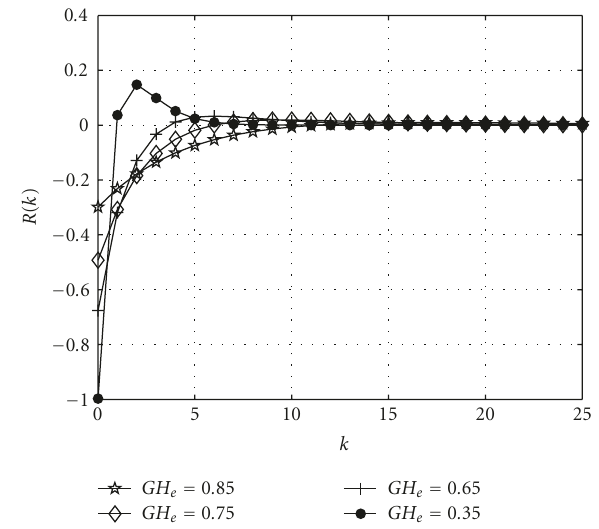
Figure 5: Function R ( k ) defined as the second derivative of Z ( k ).